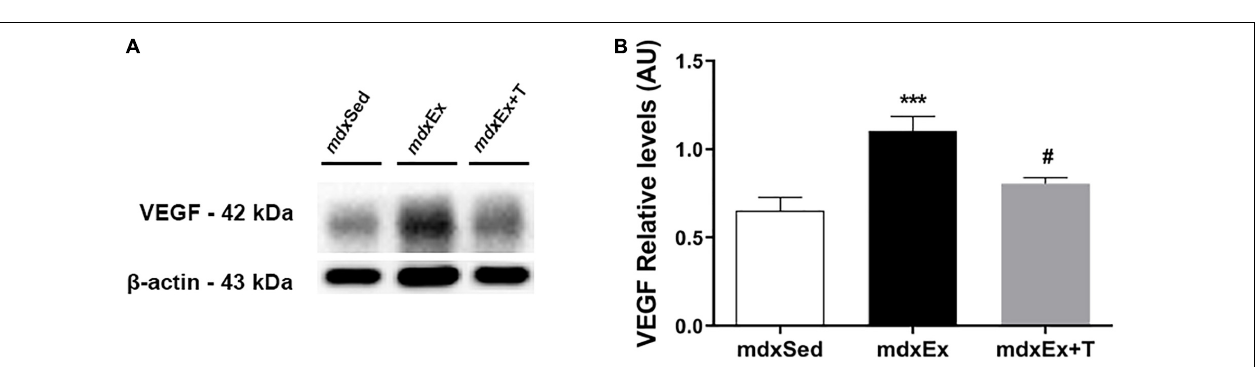
dystrophic features of adult mdx mice by making them